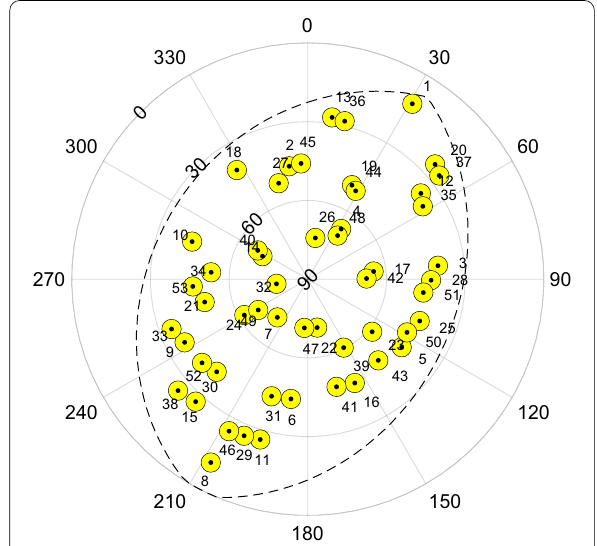
Fig. 1 Baseline mid-point skyplot for VGOS-B session B20023. Shown are the scans represented at the mid-point of the baseline Ishioka-Onsala. The common horizon of the two sites is depicted as a dashed line. Scans are represented as yellow circles with their corresponding scan number in the order of